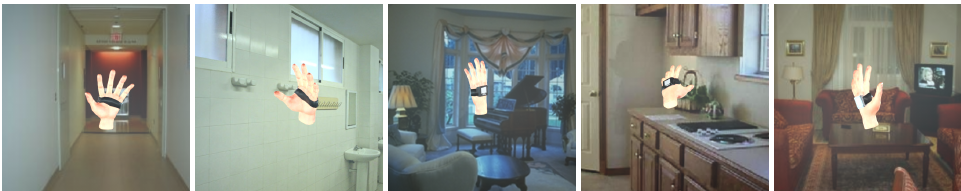
Figure 5. Examples of hand-movement animation frames with motion blur.